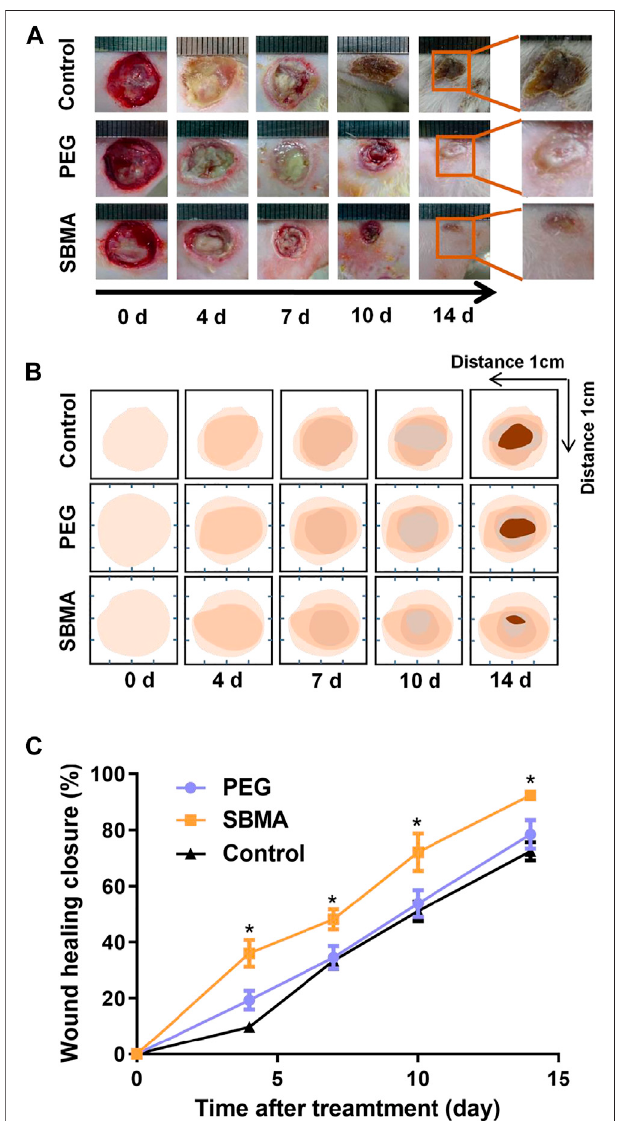
FIGURE 2 | SBMA and PEG hydrogels accelerate healing in pressure ulcers. (A) Generalobservation ofthewoundhealingextentonday 0,4,7,10, and 14 after treatments of PEG and SBMA hydrogels. The unit length in the images was 1 mm. (B) Schematic diagram that mimicking wound healing process in two groups. (C) Statistical summary of the wound healing closure of pressure ulcer in each group. Signi fi cant difference is indicated as * p < 0.05, compared to the PEG group, n (cid:1) 3 –